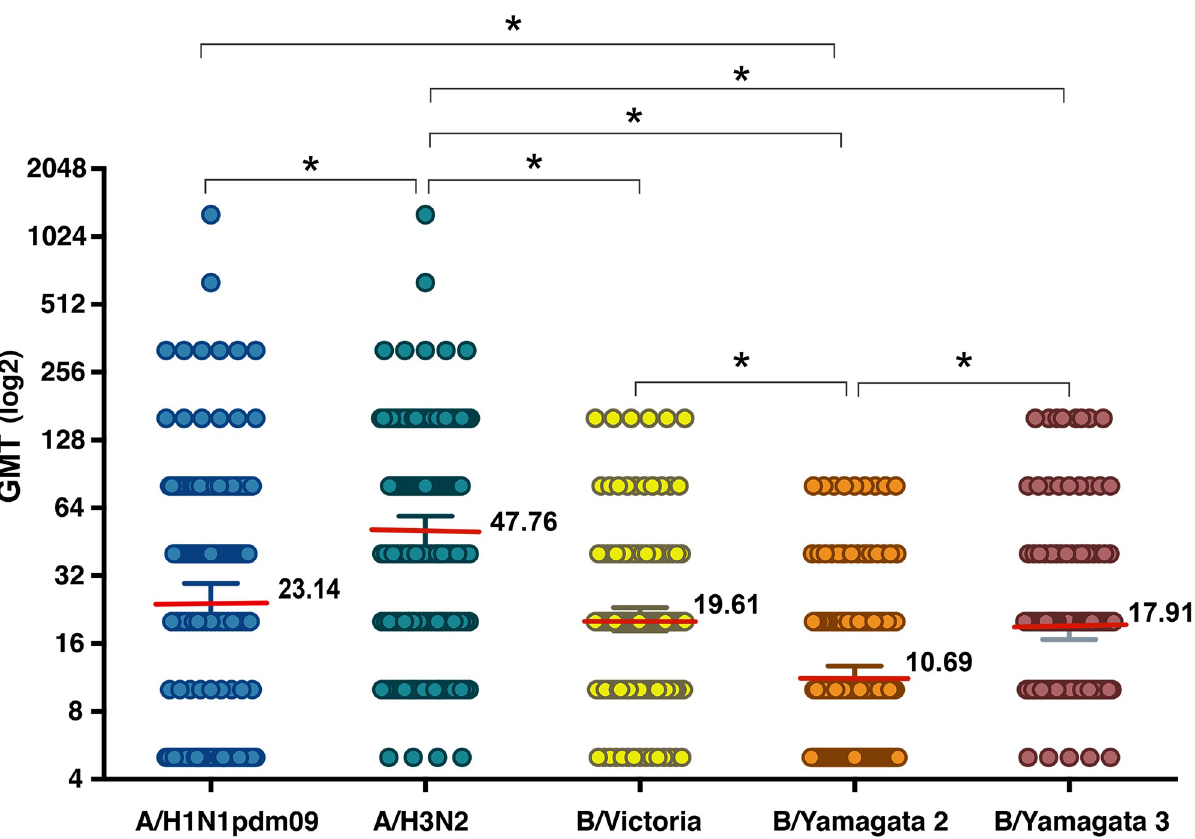
Fig 1. Comparison of the geometric mean titers among influenza type or subtype in the older adults. The colored circles are defined as influenza virus: A) A/H1N1pdm09 (A/Thailand/CU-CN364/2017, purple), B) A/H3N2 (A/Thailand/CU-B36461/2018, yellow), C) B/Victoria (B/Thailand/ CU-B31196/2019, green), D) B/Yamagata 2 (B/Massachusetts/02/2012, blue) and E) B/Yamagata 3 (B/Thailand/CU-B26097/2018, pink). The Y-axis indicates the geometric mean titer (GMT), and the X-axis showed influenza type or subtype. The red line indicates the GMT for individual influenza virus. Error bars revealed 95% confidence intervals (95% CI). The asterisk refers to a significance level < 0.0001.